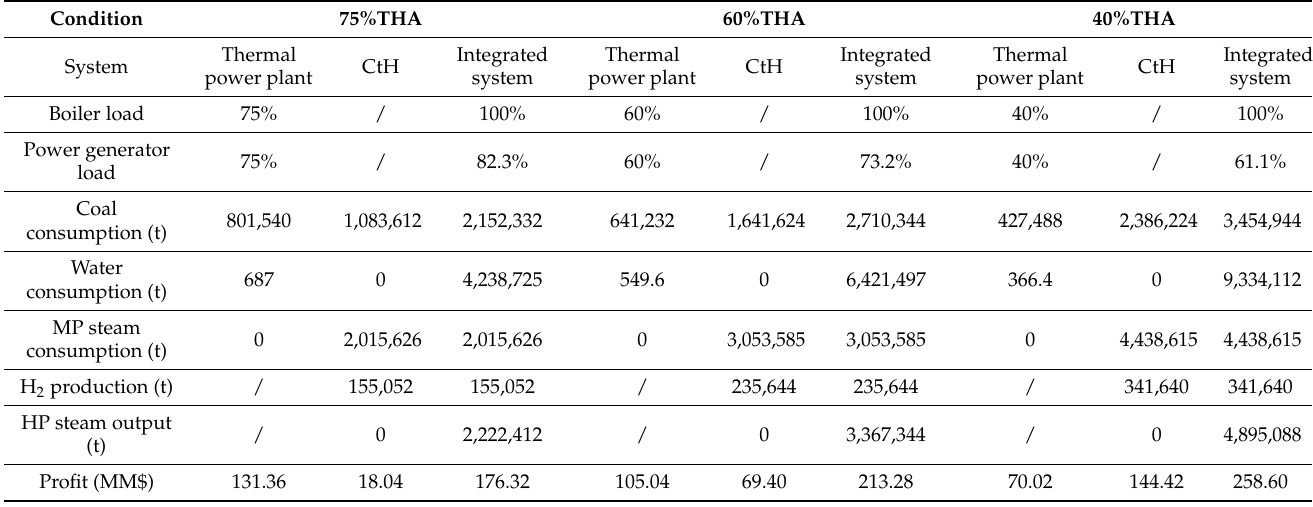
Table 5. Comparison of the integrated system and independent systems under fixed conditions.